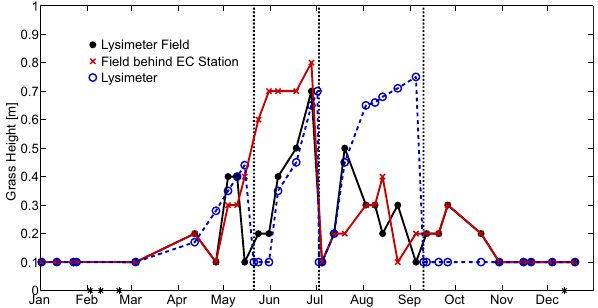
Figure 9. Grass heights at the lysimeter field, the lysimeter de- vices, and the field behind the EC station for 2012. The grass length at the lysimeter devices was reconstructed by comparing grass length measurements of the lysimeter field with the observa- tions of the surveillance system. The star (*) indicates the presence of a snow cover. Grass cutting dates on lysimeter devices are marked by dashed lines.